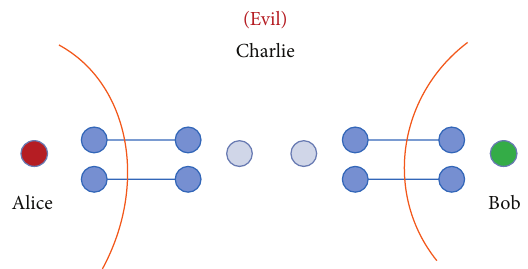
Figure 12: The scenario of participant attack 1 in which Charlie (controller) steals the secret messages by the nonlocal swap gate scheme.